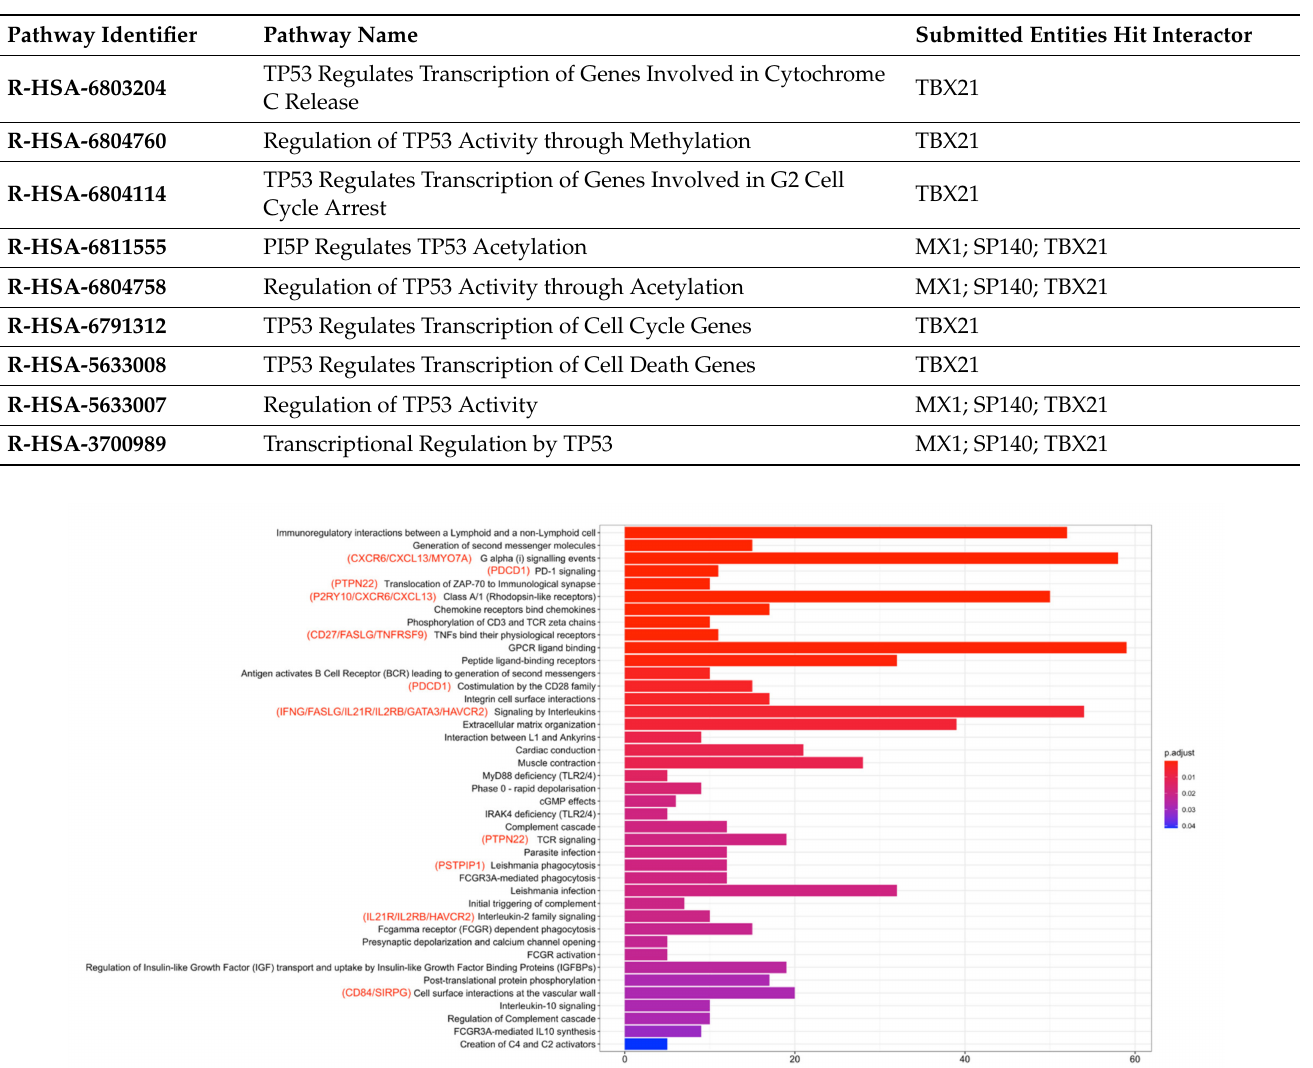
Table 2. Reactome pathway analysis for crosstalk gene with CD8Tex feature from the DEG and DMR analysis of high-low and low-high CMS1 patients.